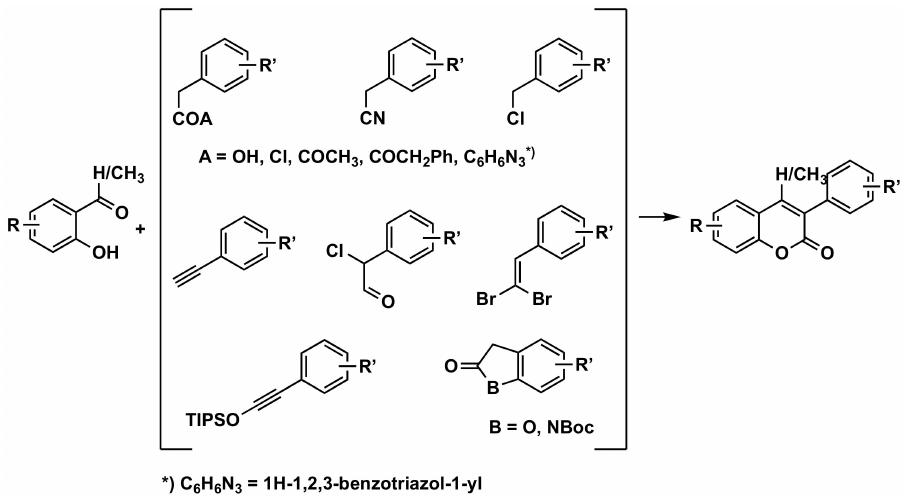
Figure 4. One of the synthetic routes to obtain 3-phenylcoumarins: construction of the coumarin from o